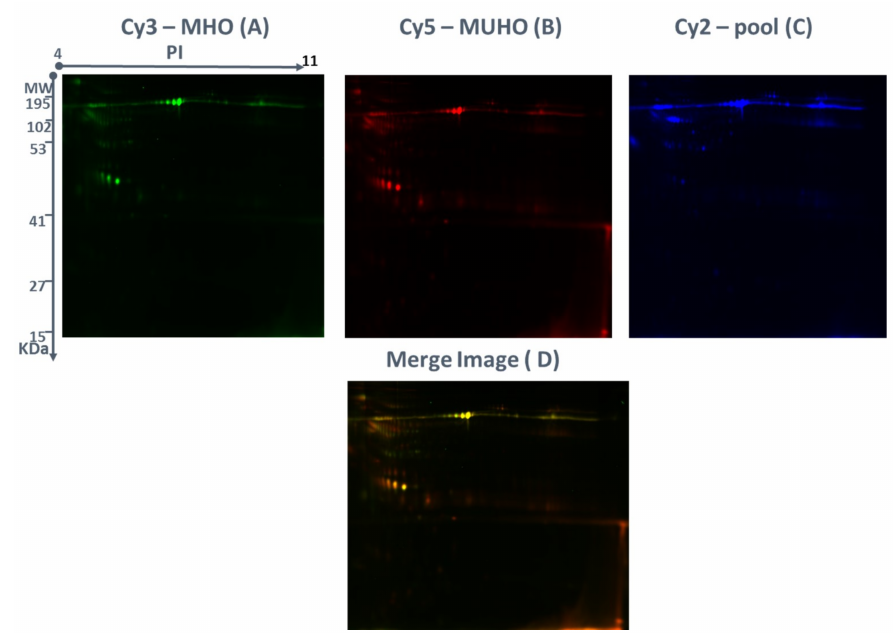
Figure 1. Representative fluorescent protein profiles using two-dimensional di ff erence in gel electrophoresis (2D-DIGE) containing ( A ) a metabolically unhealthy obese (MUHO) sample labeled with Cy5, ( B ) a metabolically healthy obese (MHO) sample labeled with Cy3, and ( C ) a pooled internal control labeled with Cy2. Proteins were separated on IPG strip (pH 3–11) in the first dimension followed by 12.5% PAGE in the second dimension electrophoresis. Images were captured using a Typhoon 9400 Variable Mode. ( D ) An overlay of Cy3 / Cy5 images is shown.